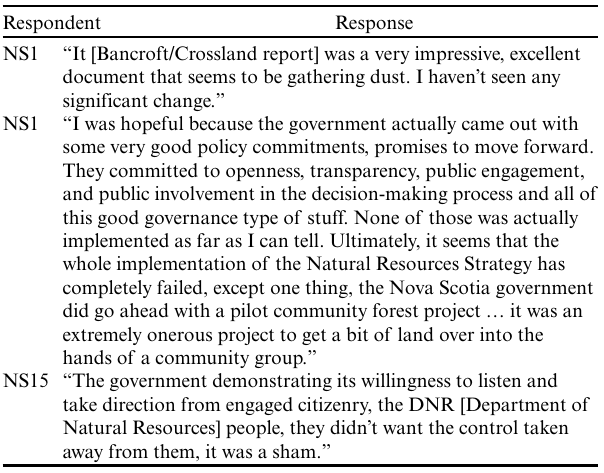
Table 5. Nova Scotia stakeholder comments on natural resource